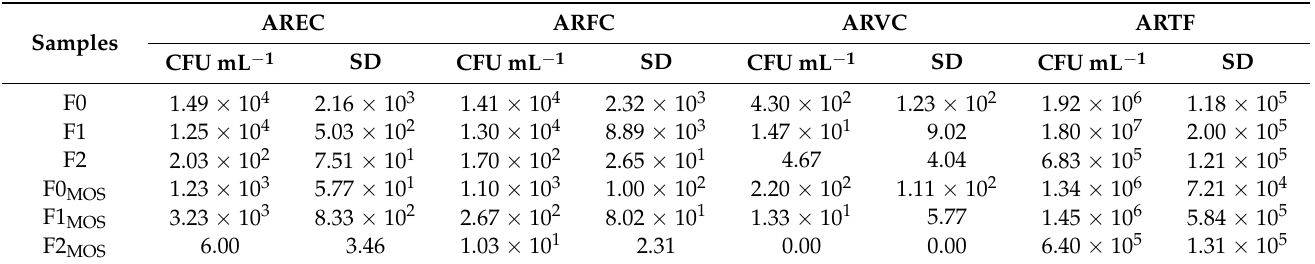
Table 3. Abundance of antibiotic-resistant bacteria in